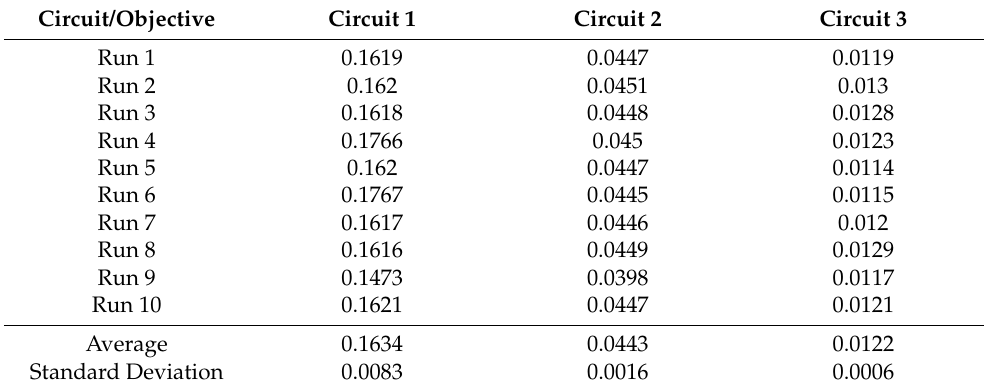
Table 11. Overall objective function values in 10 successive runs for different circuits. Circuit/Objective Circuit 1 Circuit 2 Circuit